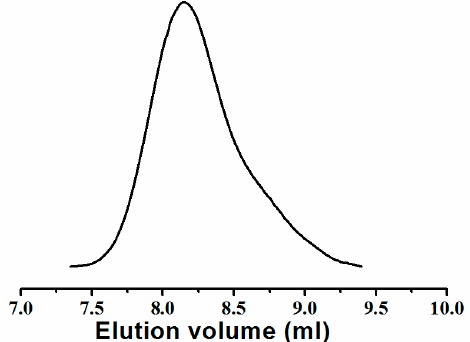
Figure 2. Gel permeation chromatography (GPC) curves of the polymer obtained from the DITP of n -